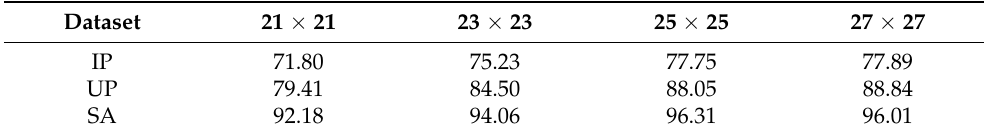
Table 4. Performance of different window sizes (OA).